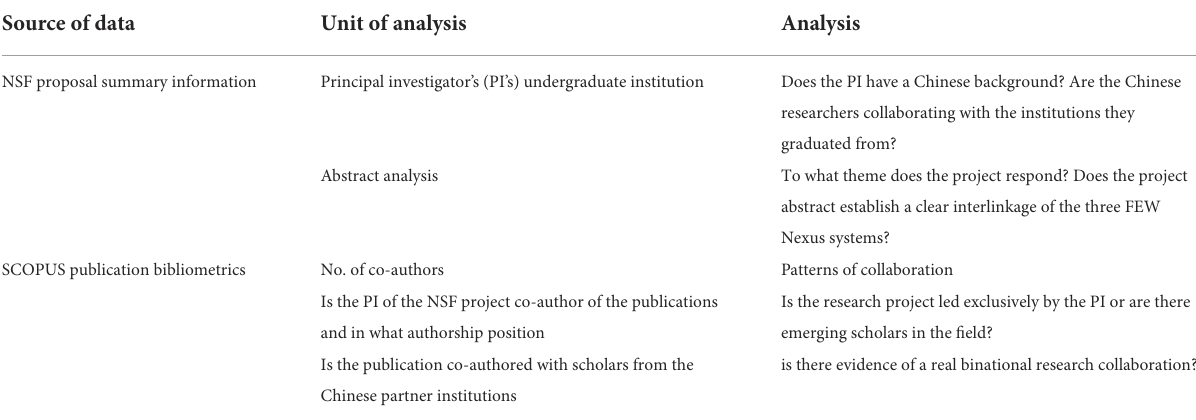
TABLE 1 Operationalization of